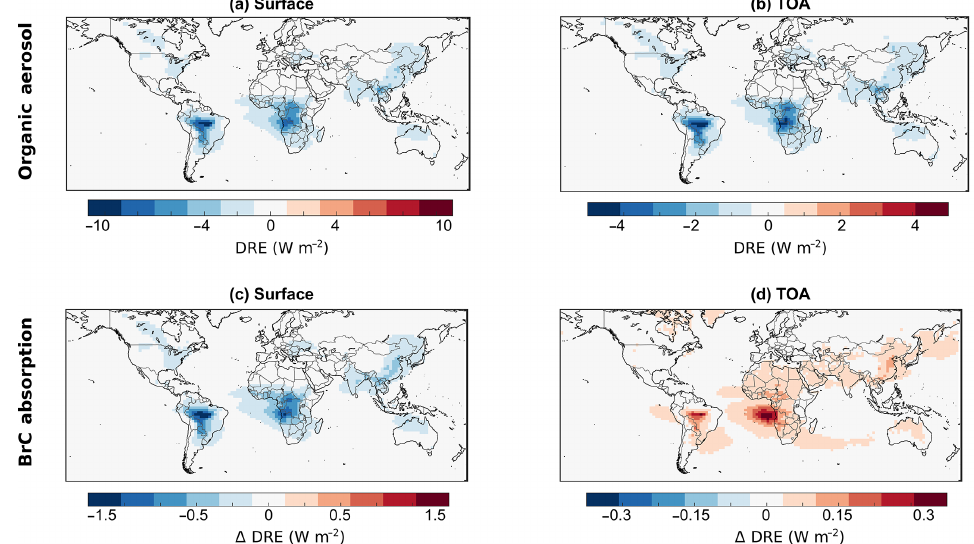
Figure 6. Annual mean all-sky DRE values for 2007 (Wm − 2 ) . The top two panels are the DRE values for organic aerosol from the case 2 simulation including BrC at (a) the surface and (b) TOA. The bottom two panels are the change in DRE values for absorption by BrC calculated as the difference between the DRE values for organic aerosol from the case 2 simulation and the base case simulation (without BrC) at (c) the surface and (d) TOA. Table 7. Global annual mean LW and SW flux differences and resulting DRE values for 2007 at TOA and the surface. The values for organic aerosol are shown for both the base case simulation without BrC and the case 2 simulation including absorbing brown carbon. The DRE values for BrC absorption are calculated as the difference between the DRE of organic aerosol from case 2 minus the base case. Organic aerosol BrC absorption Base case Case 2 Case 2 – Base case TOA DRE, clear sky (Wm − 2 ) − 0.33 − 0.31 + 0 .